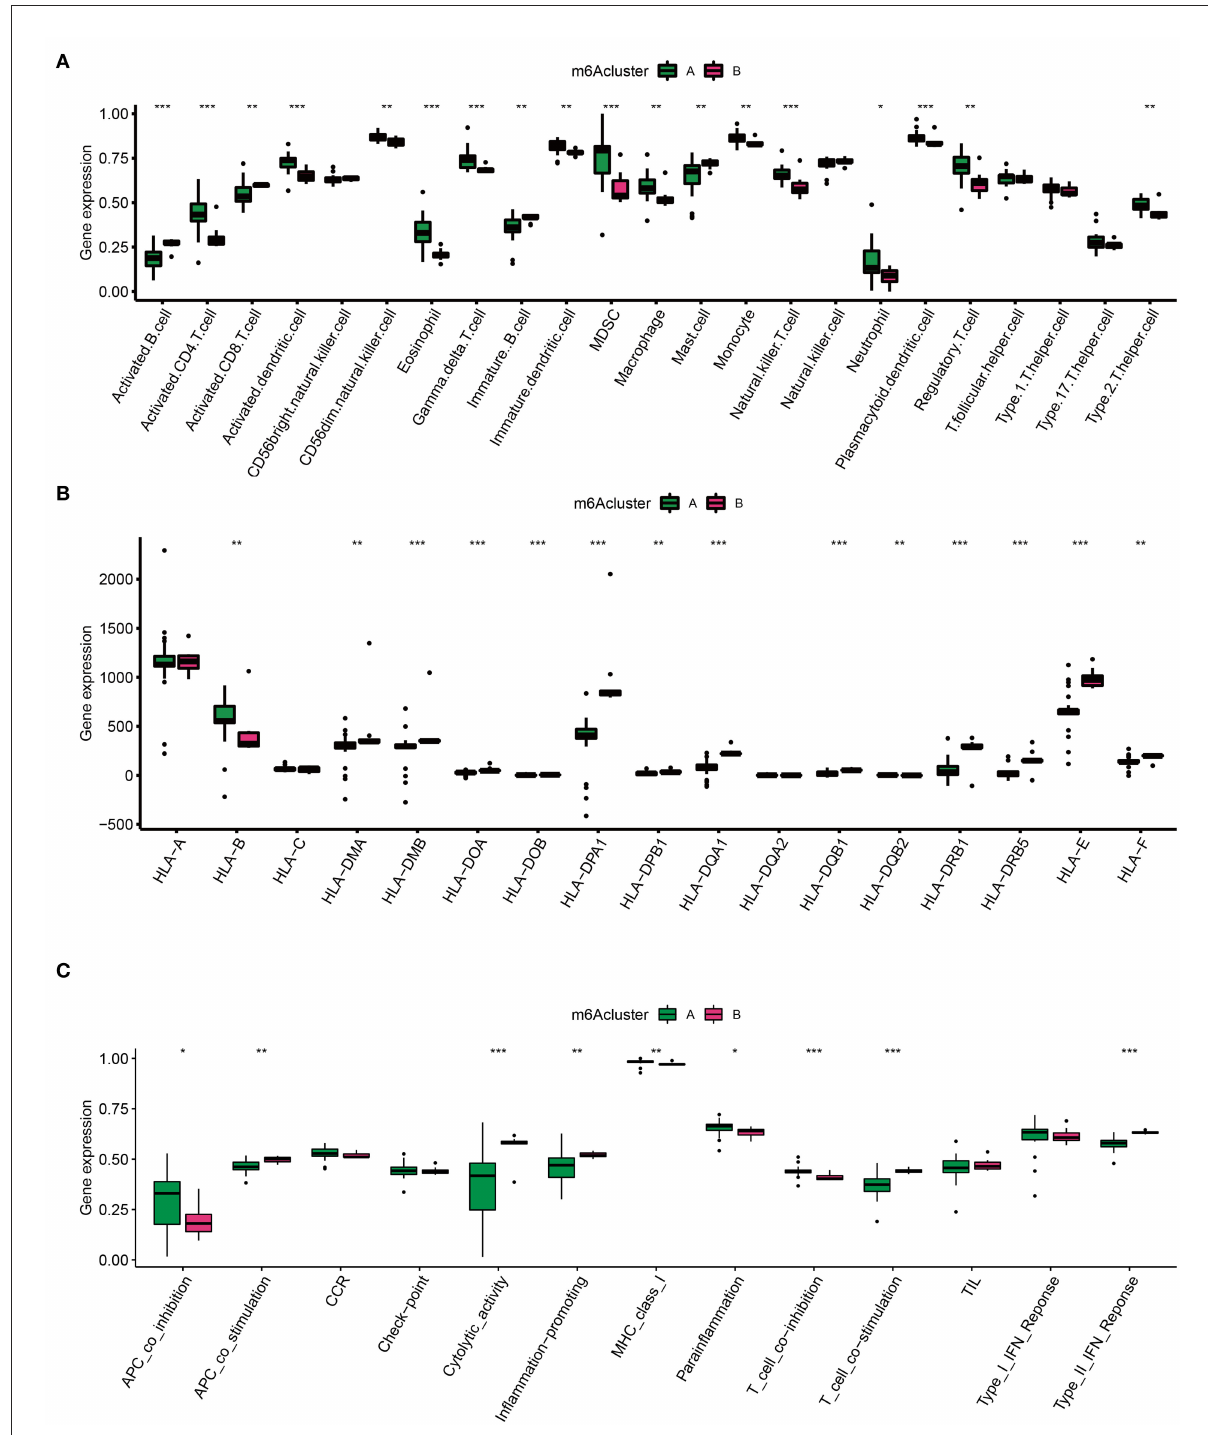
FIGURE5 Immune microenvironment (IME) characteristics in two m6A AD clusters. (A) The immune cell infiltration status in two clusters. (B) The expression landscape of HLA family genes in two clusters. (C) The evaluation of immune response gene set in two clusters. * p < 0.05, ** p < 0.01, *** p < 0.001 indicated the statistical significance of